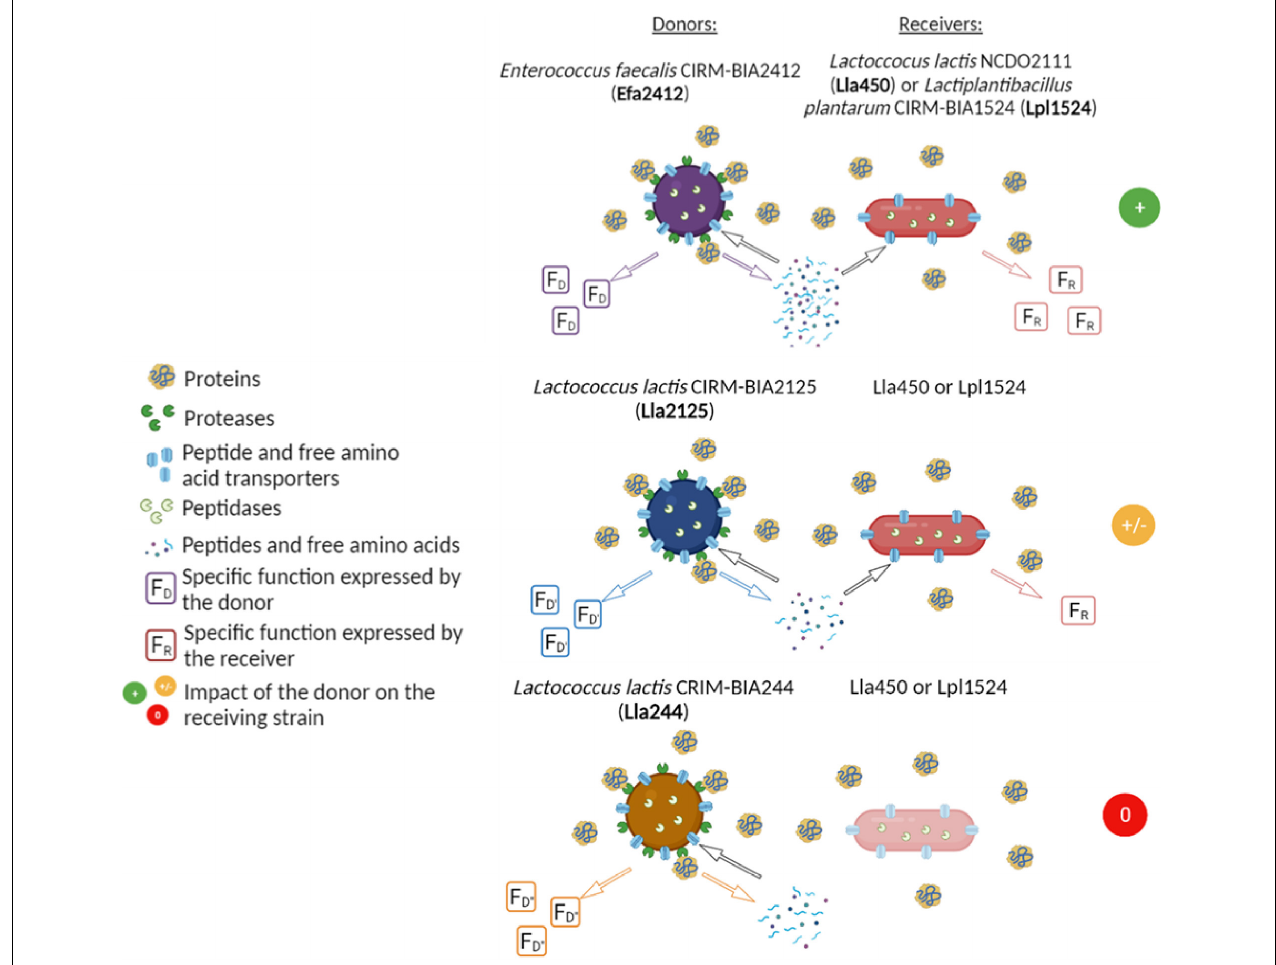
FIGURE 1 | Interactions between proteolytic strains (=donors) and non-proteolytic strains (=receivers) observed in a chemically-defined medium containing caseins and lupin proteins as sole nitrogen sources (Canon et al., 2021).